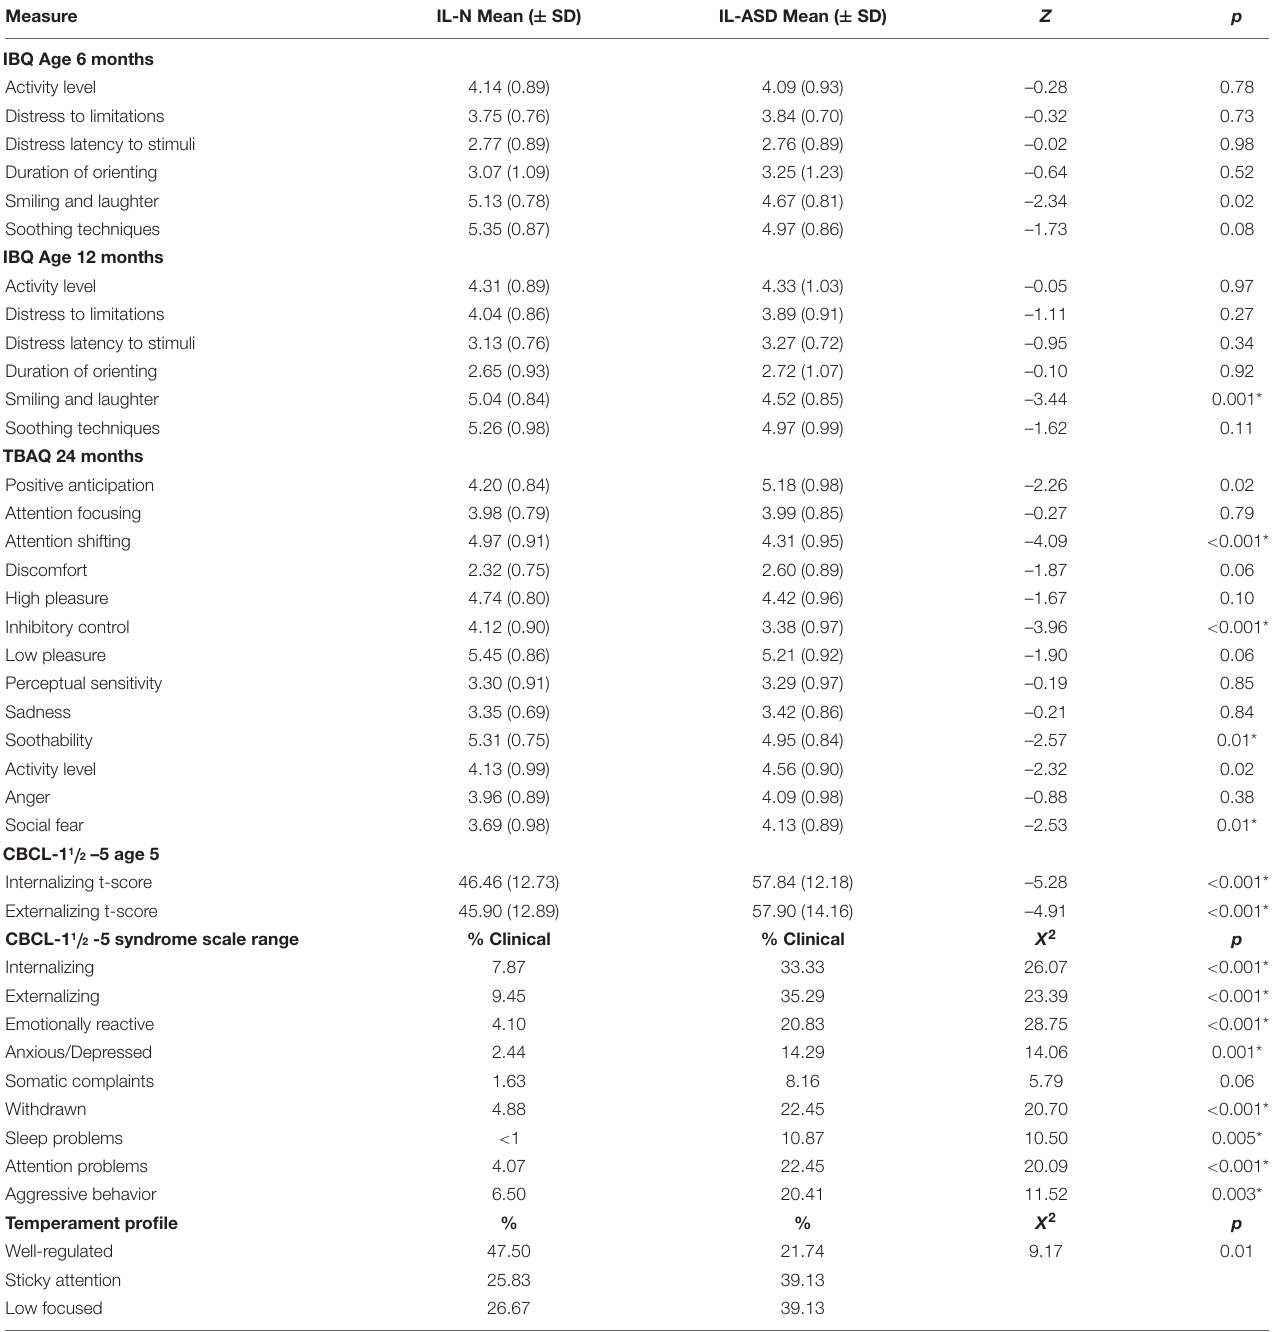
TABLE 2 | Group differences on